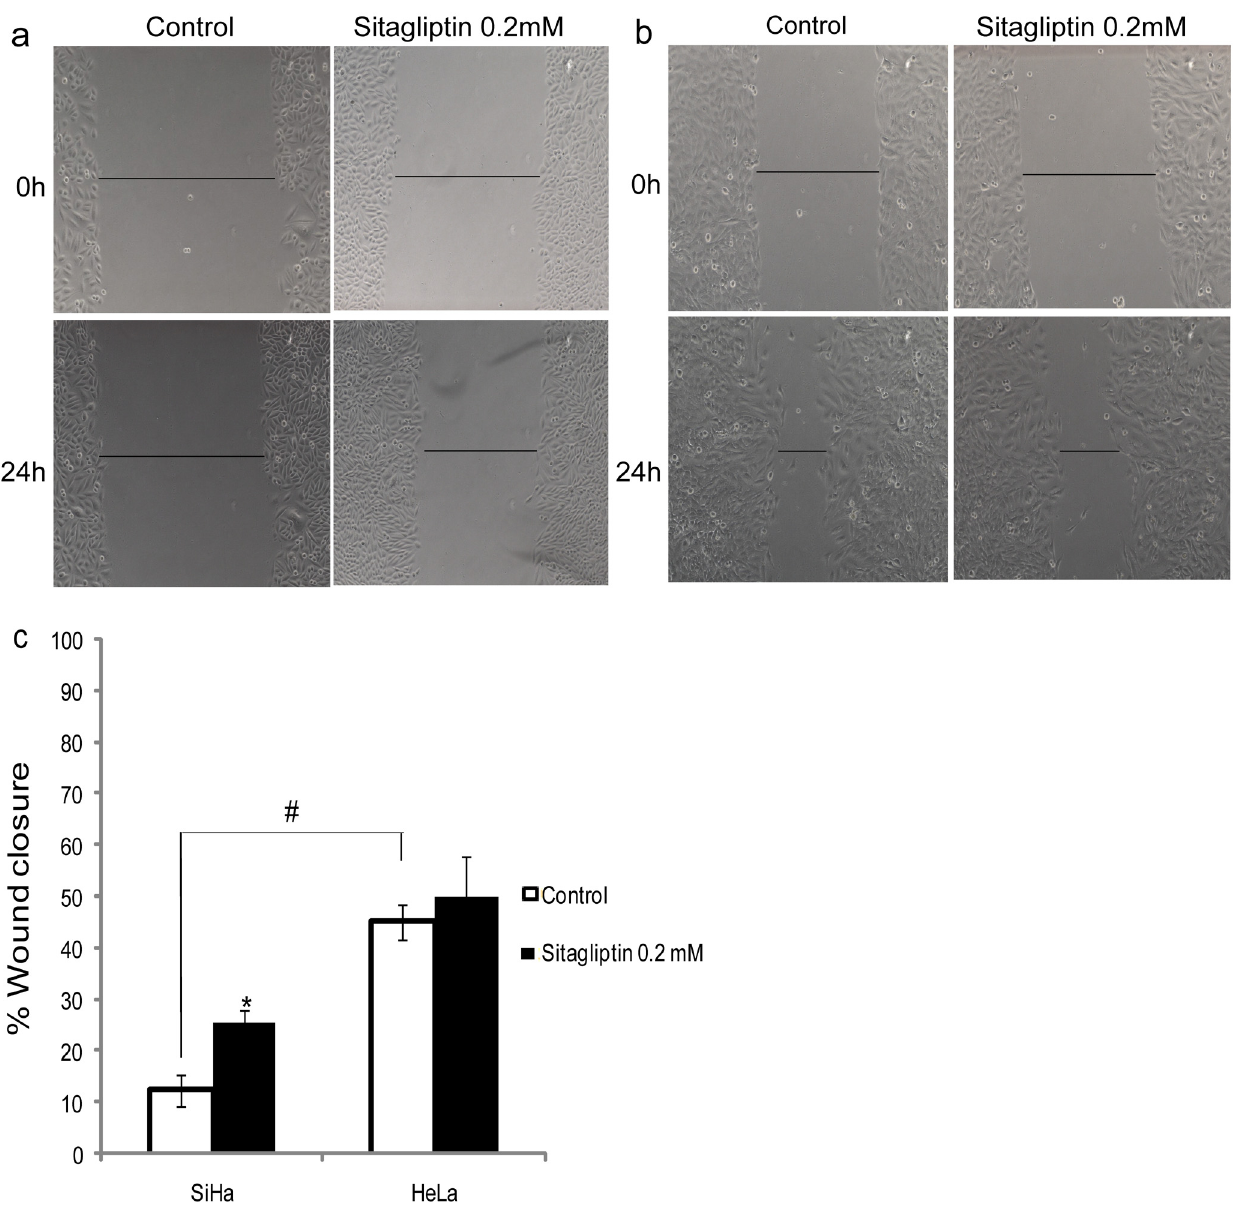
Fig 4. Cell migration using the Wound-healing assay. SiHa (a) and HeLa (b) cervical cancer cells were analyzed 24 h after scratching in the absence (control) and presence of 0.2 mM sitagliptin phosphate. (c) Quantification of the wound closure of cervical cancer cells in the absence (control) and presence of sitagliptin phosphate. Results are mean values ± SD (n = 3). * Indicates statistical significance when the sitagliptin phosphate group was compared to the respective control group. #Indicates statistical significance when controls were compared (ANOVA followed by Tukey ’ s test, p (cid:1)